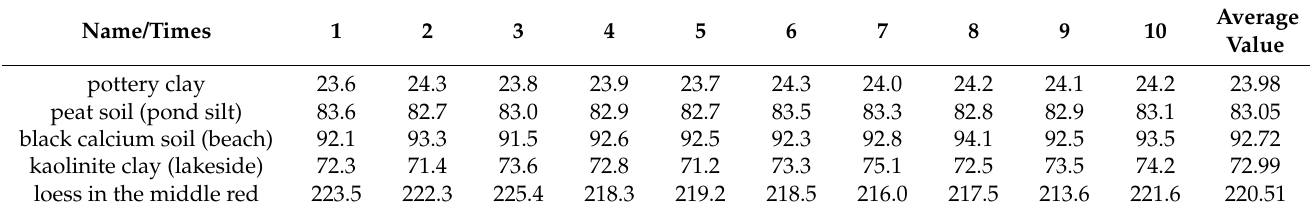
Table 2. Resistivity value of standard soil resistivity measurement purchased (unit: Ω · m).